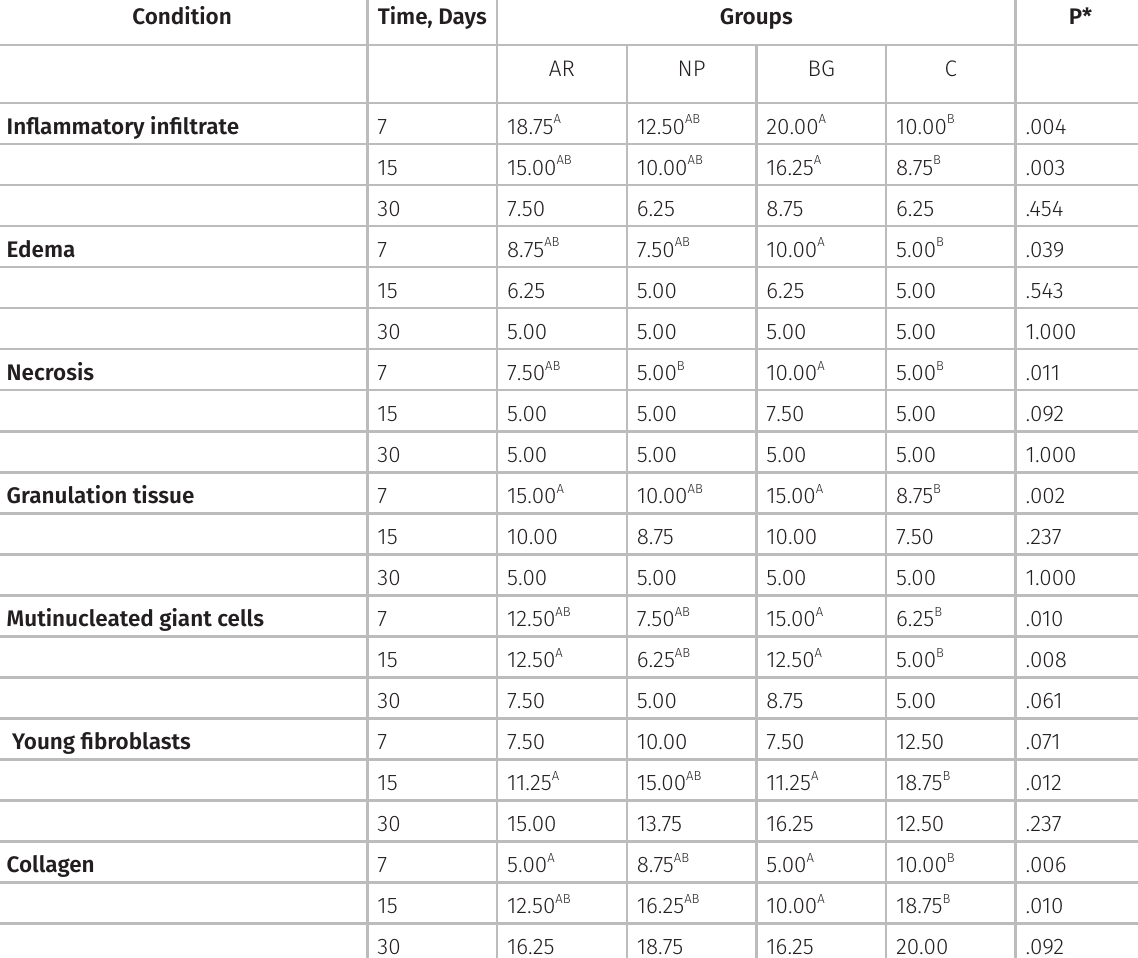
Table II. Mean of the scores attributed to the materials, after the time intervals of 7, 15 and 30 days, for the seven conditions evaluated a